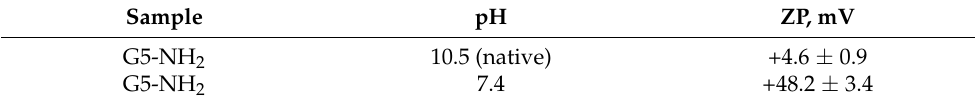
Table 2. Summary of the zeta potentials for G5-NH 2 PAMAM